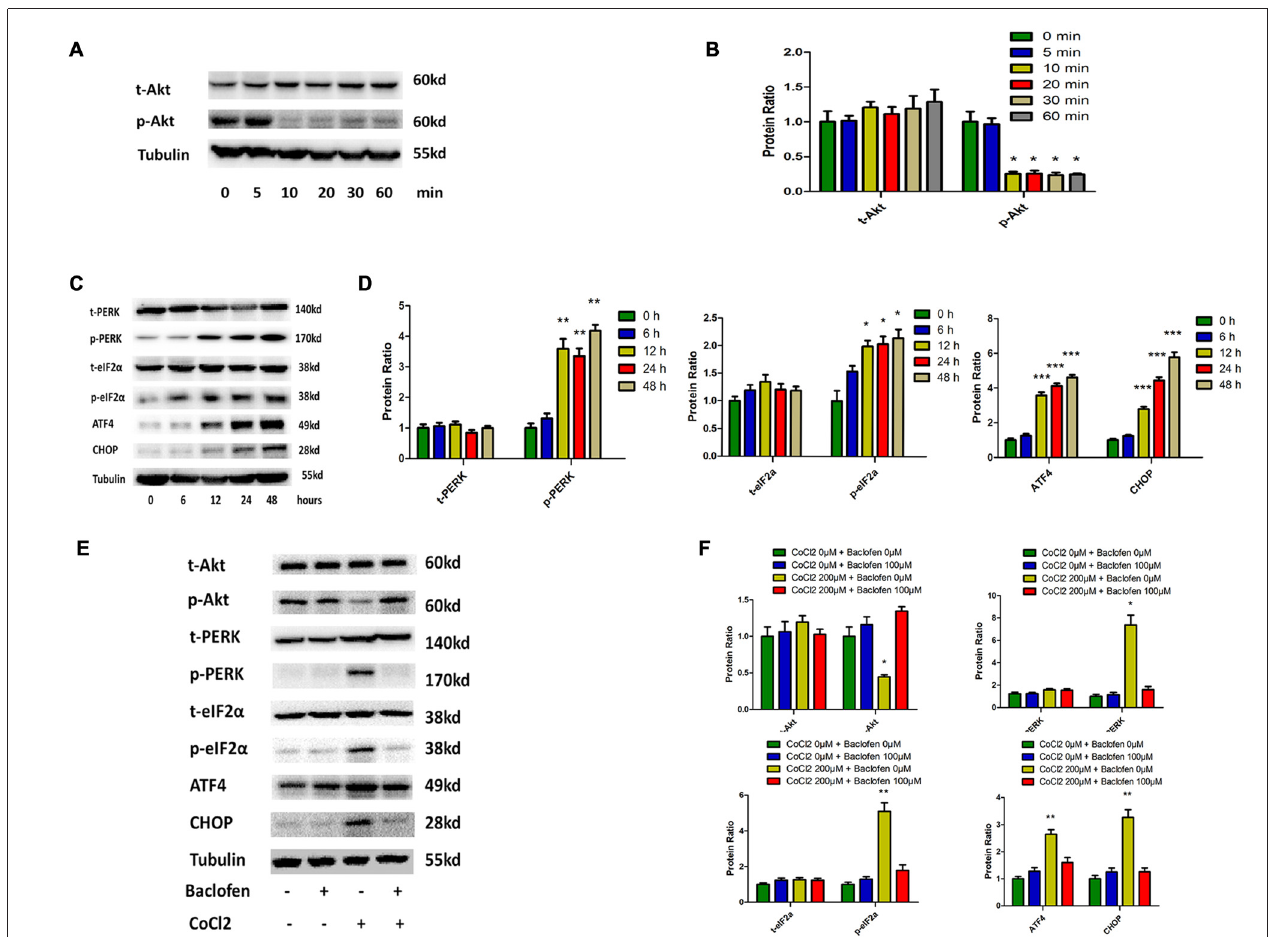
FIGURE 3 | Phosphorylation of Akt is reduced and protein kinase RNA (PKR)-like ER kinase (PERK)-eIF2 α -ATF4 pathway is activated in hypoxia-treated RGCs, and baclofen can reverse the change. (A,B) Time dependent expression of total Akt and phosphorylated Akt induced by 200 µ M CoCl 2 . Representative experiments are presented. The detected protein bands are normalized to the signal of α -tubulin. Protein level in each group was expressed as the value relative to the control. The data represent the mean ± SD of three independent experiments. ( ∗ p < 0.05, compared to control). (C,D) Time dependent expression of indicated proteins induced by 200 µ M CoCl 2 . (E,F) Expression of indicated proteins detected by Western blotting in RGCs treated with baclofen and CoCl 2 for 24 h as presented. Protein expression is shown as percentage of control cells unexposed to chemotherapeutic drugs. The data represent the mean ± SD of three independent experiments ( ∗ p < 0.05, ∗∗ p < 0.01, ∗∗∗ p < 0.001 compared to cells without CoCl 2 or baclofen